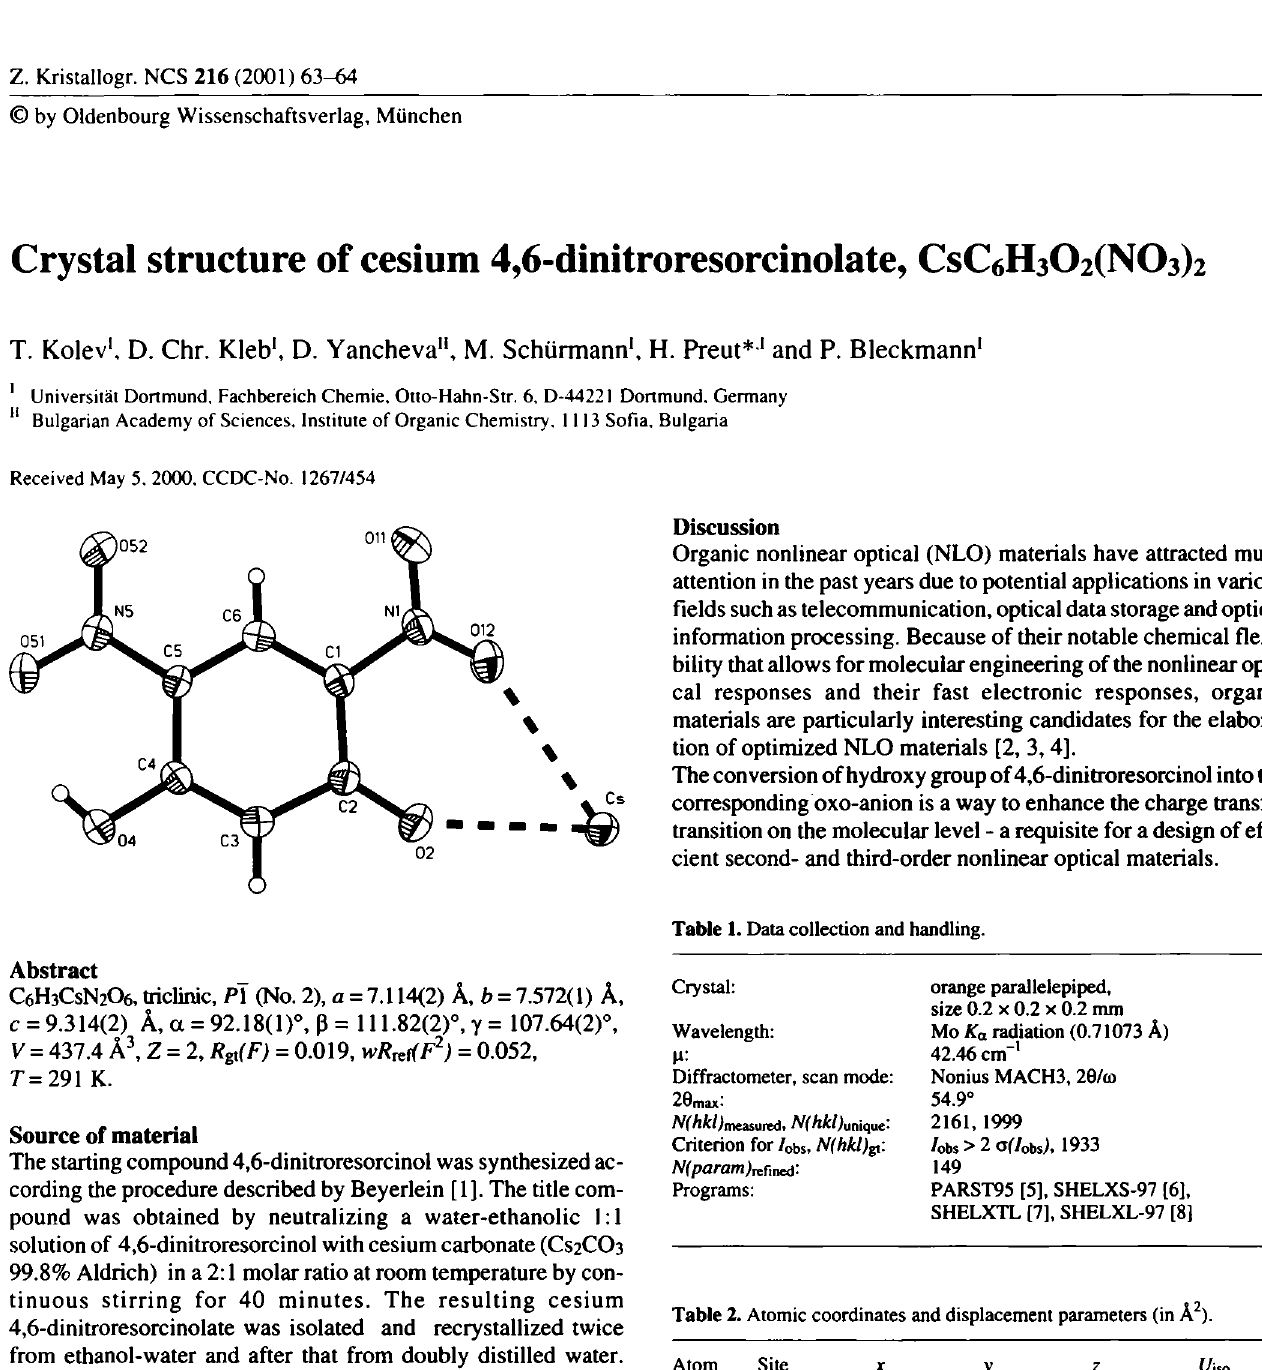
Table 3. Atomic coordinates and displacement parameters (in Ä 2 ).